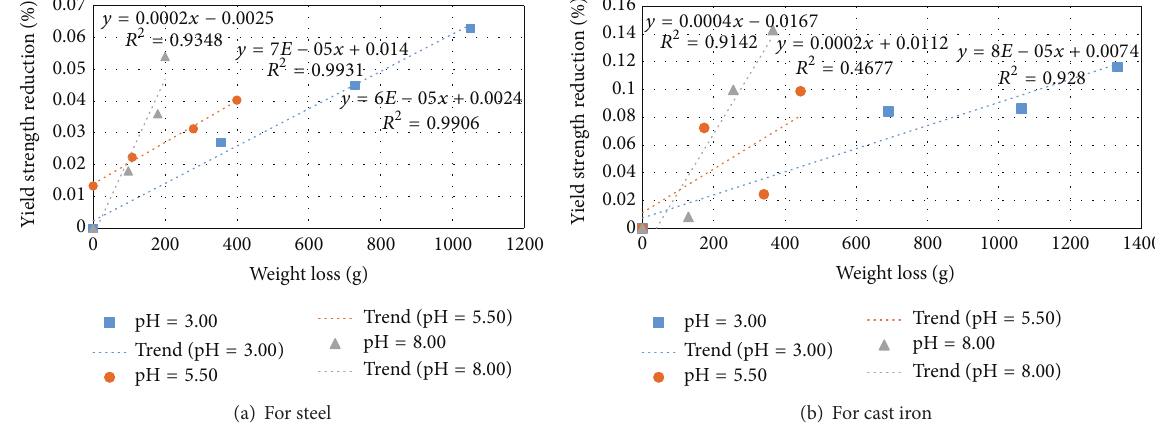
Figure 11: Tensile strength reduction with weight loss.